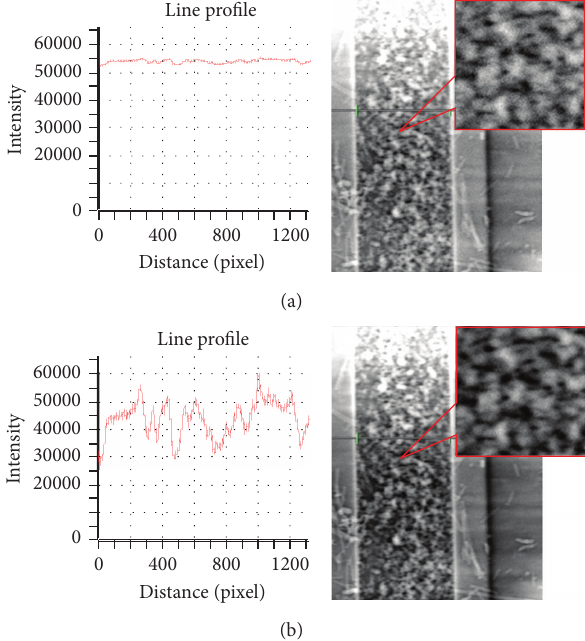
Figure 3: The intensity of projection image. (a) Original projection image. (b) Projection image after